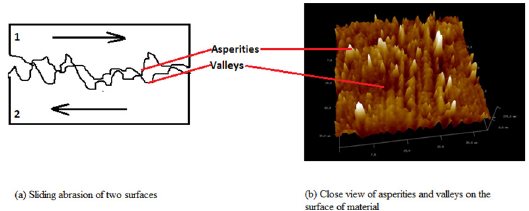
Figure 7. Image of a surface showing asperities and valleys at microscopic level.